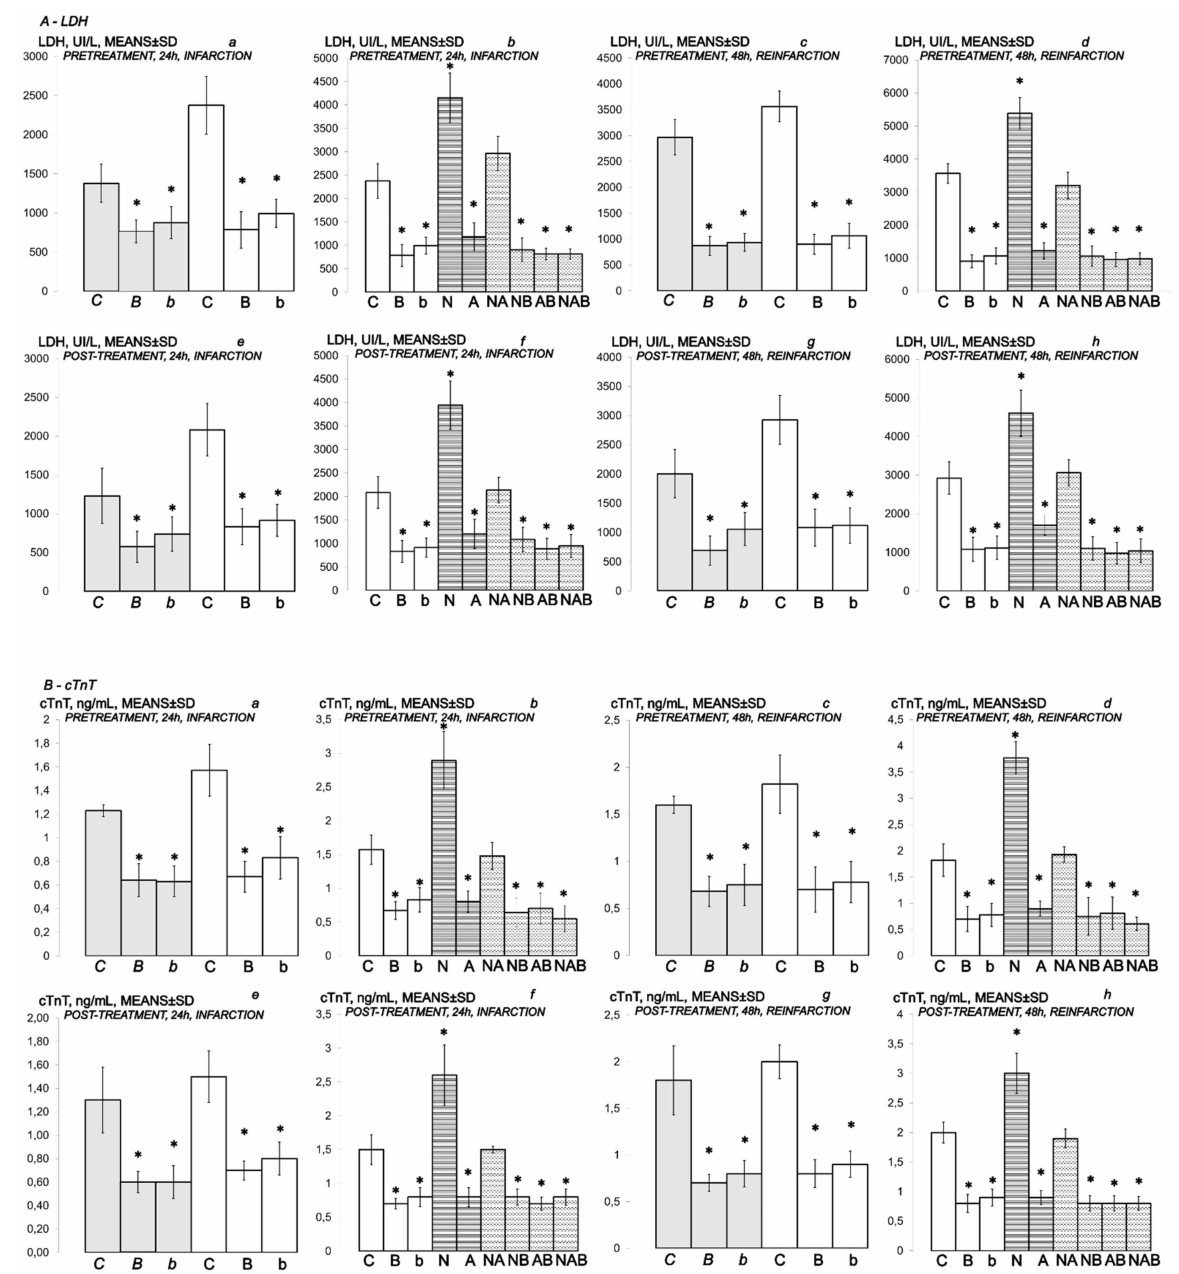
Figure 11. ( A , B ) Myocardial infarction (one isoprenaline challenge) and re-infarction (two isopre- naline subsequent challenges) in isoprenaline- treated rats (75 mg/kg sc (gray bars), 150 mg/kg sc (white bars)). Serum values of cardioselective enzymes A-LDH (UI/L) and B-cTnT ng/mL. Rats treated with the smaller dose of isoprenaline, 75 mg/kg sc (gray bars, italic letters), received med- ication (BPC 157 (10 ng/kg ( b ), 10 µ g/kg ( B ) i.p. or saline (5 mL/kg i.p. ( C )). Rats treated with the higher dose of isoprenaline, 150 mg/kg sc (white bars, normal letters), received medication (BPC 157 (10 ng/kg (b), 10 µ g/kg (B) i.p. or saline (5 mL/kg i.p. (C)) or L-NAME (5 mg/kg i.p. (N)), L-arginine (200 mg/kg i.p. (A)) (horizontal line bars) or these agents combination (L-NAME + L-arginine (NA), L-NAME + BPC 157 (NB), L-arginine + BPC 157 (AB), L-NAME + L-arginine + BPC 157 (NAB)) (dashed horizontal lines bars). Therapy was given (i) 30 min before isoprenaline ( PRETREATMENT , prophylactic regimen ( a – d )), or, alternatively, (ii) at 5 min after isoprenaline (75 mg/kg s.c. or 150 mg/kg s.c.), at day 1 and at day 2 ( POST-TREATMENT , therapeutic regimen ( e – h )). Ten rats per each experimental group. * p < 0.05 vs. control, at